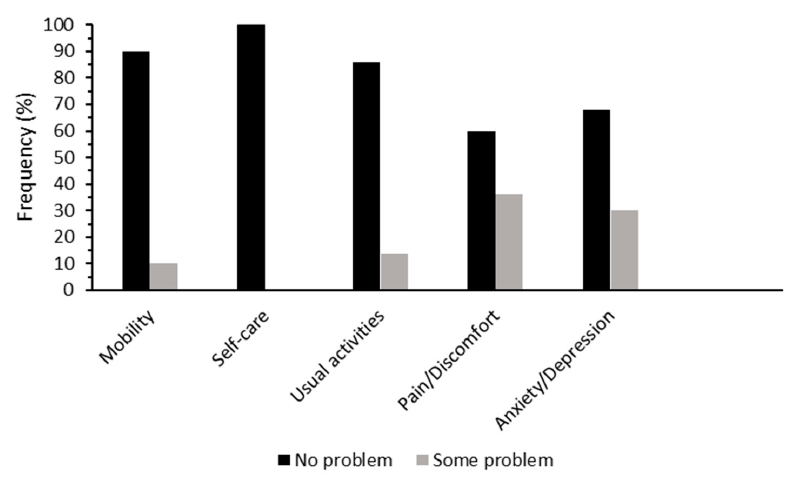
Figure 1. Percentage of postmenopausal women who had no problem (black) and some problems (grey) for the five dimensions of EuroQol-5D (EQ-5D). Table 2. Spearman’s correlations between self-reported measurements and bone parameters. EQ-5D Mobility